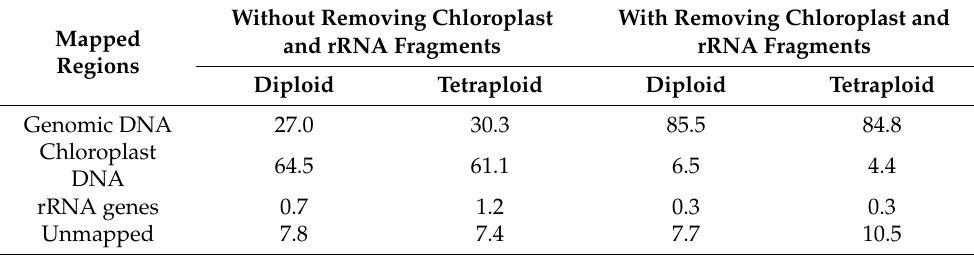
Table 1. Proportions (%) of the sequence reads aligned to different regions in the diploid or tetraploid potato genomes from the RAD-seq experiment. rRNA, ribosomal RNA.